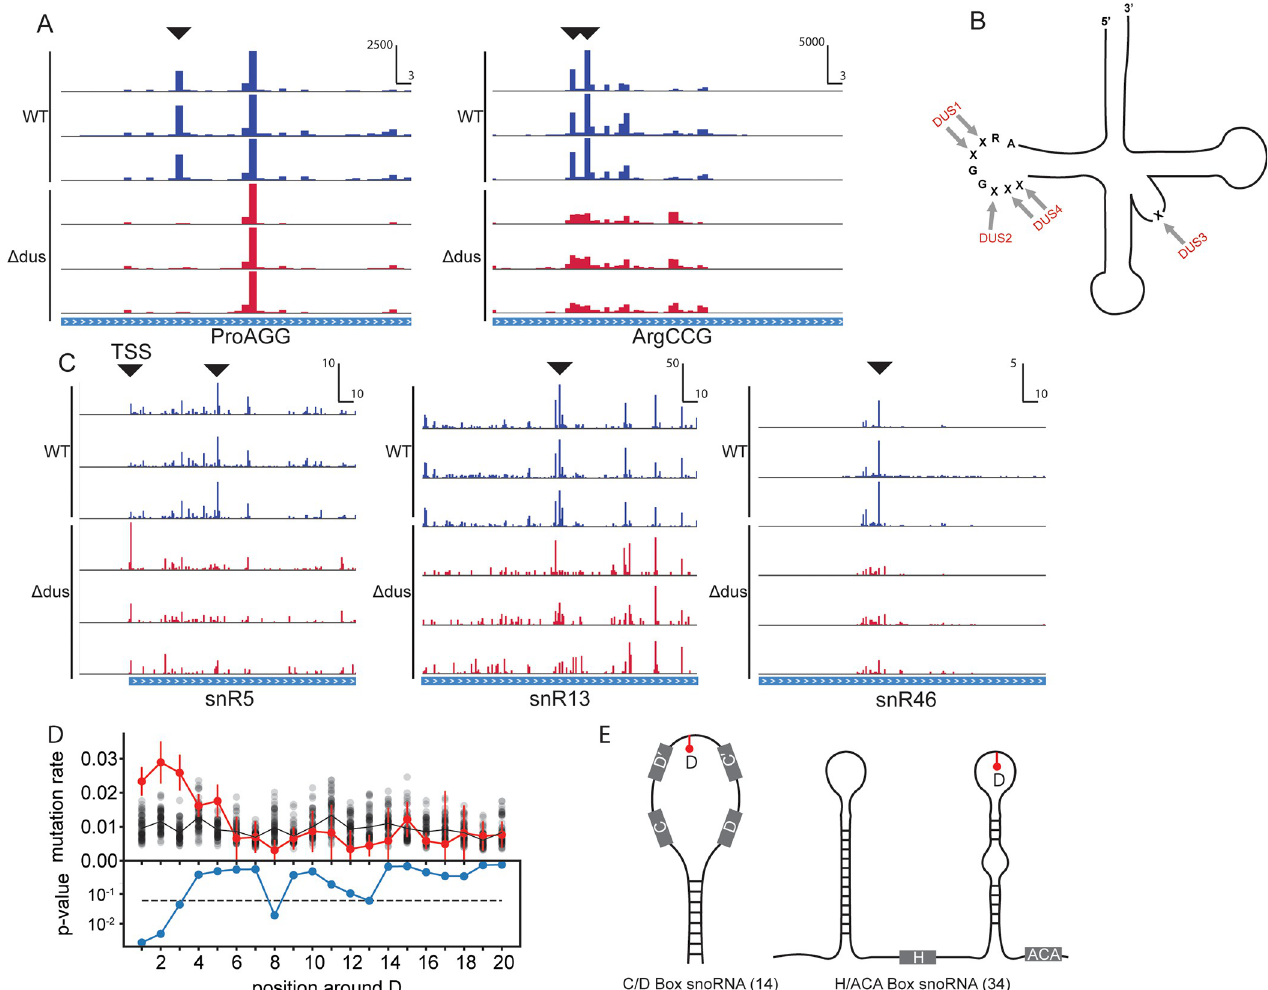
Fig 2. D-seq identifies known and novel dihydrouridine sites in structured ncRNAs. (A) Plots of cDNA end positions in Dus2 target tRNA ProAGG and Dus2, Dus4 target tRNA ArgCCG. D Peaks are highlighted. X scale in RPM and Y scale in bp. (B) Summary of known tRNA D positions and corresponding DUS. (C) Plots of cDNA end positions in snR5, snR13, and snR46 snoRNAs. D peaks are highlighted. TSS (transcription start site) of snR5. X scale in RPM and Y scale in bp. (D) snoRNA Ds occur primarily in stem-loop structures that resemble tRNA D loops. Plot of median DMS-induced mutation rate in 25 nt window flanking D site. Red trace is median DMS reactivity flanking D positions. Black dots are median DMS reactivity for randomly selected set of background positions. Blue trace is p -value for difference in DMS reactivity for sequences flanking D or background sites. (E) D sites occur in stem-loop structures of 16 H/ACA and 7 C/D box snoRNAs. The data underlying this figure can be found in S1 and S2 Tables. DMS, dimethyl sulfate; D-seq, dihydrouridine sequencing; ncRNA, non-coding RNA; snoRNA, small nucleolar RNA; TSS, transcription start site. Table). To estimate the number of false positives, we inverted the analysis (required high Z- scores in the DUS KO replicates and low Z-scores in WT replicates), which identified 5 false positives for an estimated false discovery rate for D sites in mRNA of 3.8%. Two false positives are understandable as “shadow” peaks downstream of a D (S3B Fig). The number of D sites we identified (130) represents a lower bound for the total number of D sites in yeast mRNA as we surveilled only approximately 1% of the yeast transcriptome that met the coverage threshold in all 6 libraries. These results show that interactions between DUS and mRNA [9,10] result in substantial modification and uncover dihydrouridine as a component of the mRNA epitranscriptome.